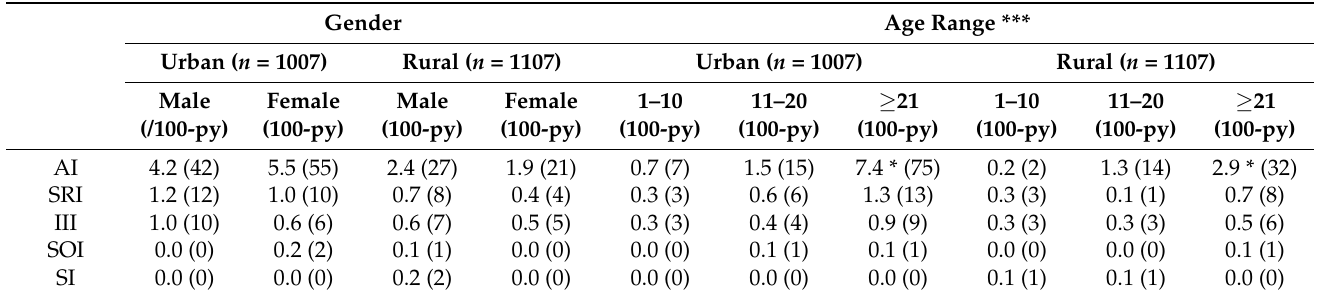
Table 4. Incidence of clinical-immunological profiles of human L. ( L. ) infantum chagasi -infection by gender and age in distinct urban and rural scenarios in the Brazilian